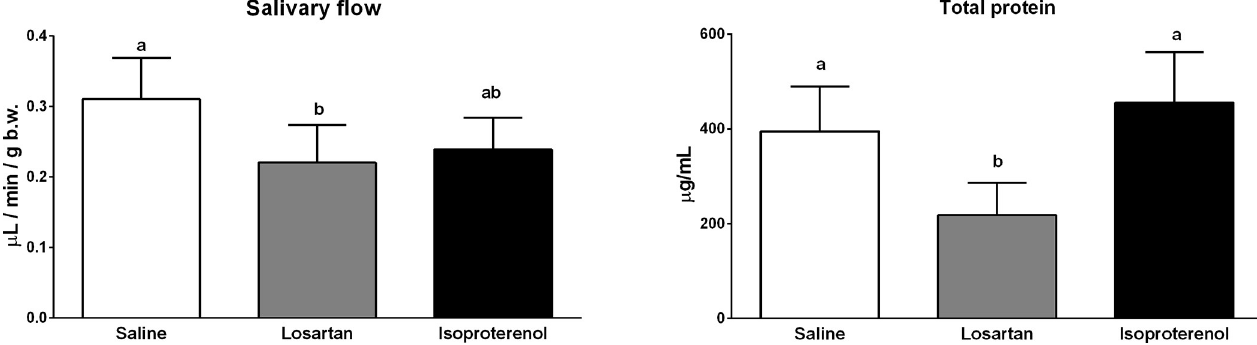
Fig 7. Salivary flow and total protein determination in control, losartan and isoproterenol groups. Data are presented as means ± standard deviation. Different letters indicate a statistically significant difference (p < 0.05) using One-way ANOVA/Tukey’s multiple comparison test for salivary flow analysis and Kruskal-Wallis/Dunn test for total protein